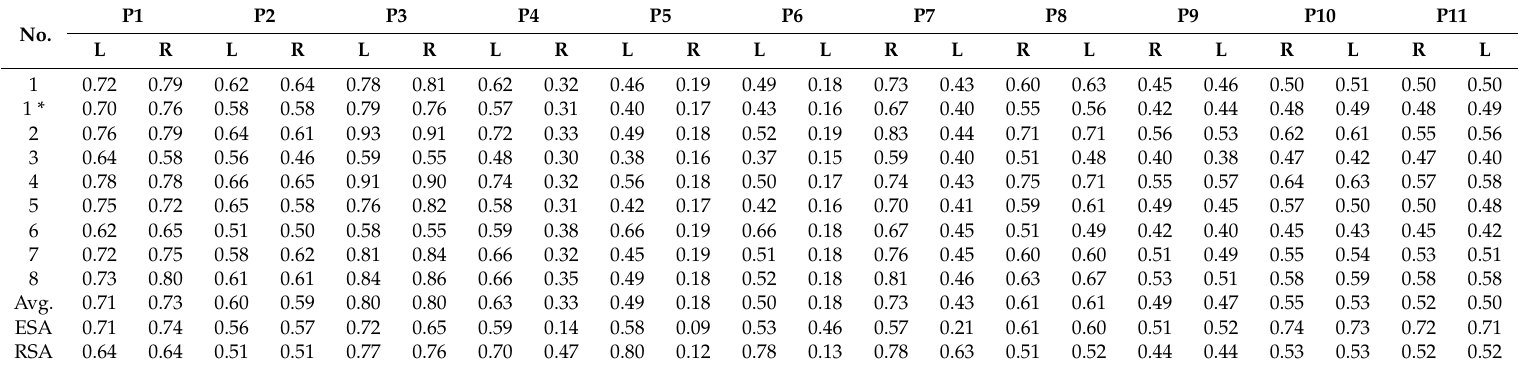
Table 7. Demand/Capacity Ratios for bridges under far-field earthquakes, Equivalent Static (ESA) and Response spectrum (RSA) analyses.